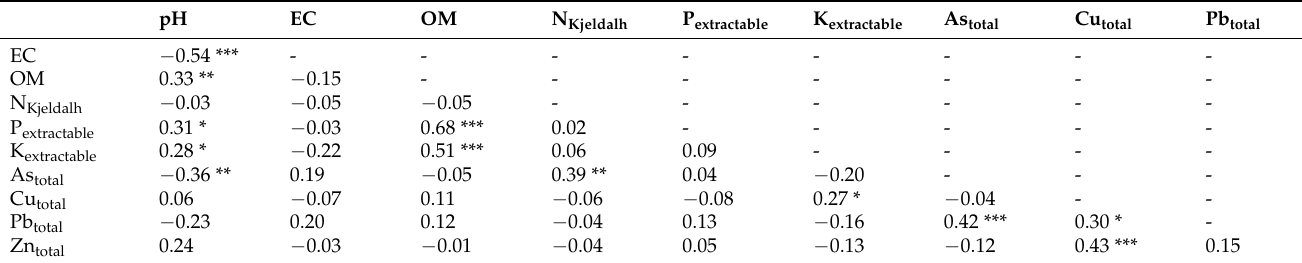
Table 1. Pearson’s correlation coefficients between soil physicochemical properties and potentially toxic elements pseudo-total concentrations (n = 65). Marked correlations are significant at (*) p < 0.05; (**) p < 0.01; and (***) p < 0.001, evidencing the strength of the associations: moderate, high, and very high,